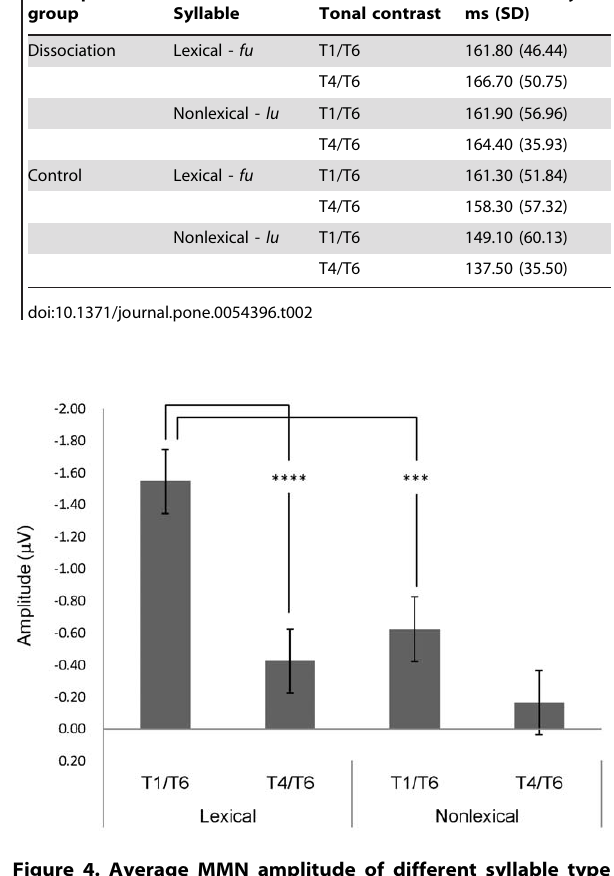
Figure 4. Average MMN amplitude of different syllable type and tonal contrast conditions. Note . T1/T6=contrast between T1 and T6, T4/T6=contrast between T4 and T6, lexical=lexical syllable, nonlexical=nonlexical syllable, ***= p , .005, ****= p , .001.